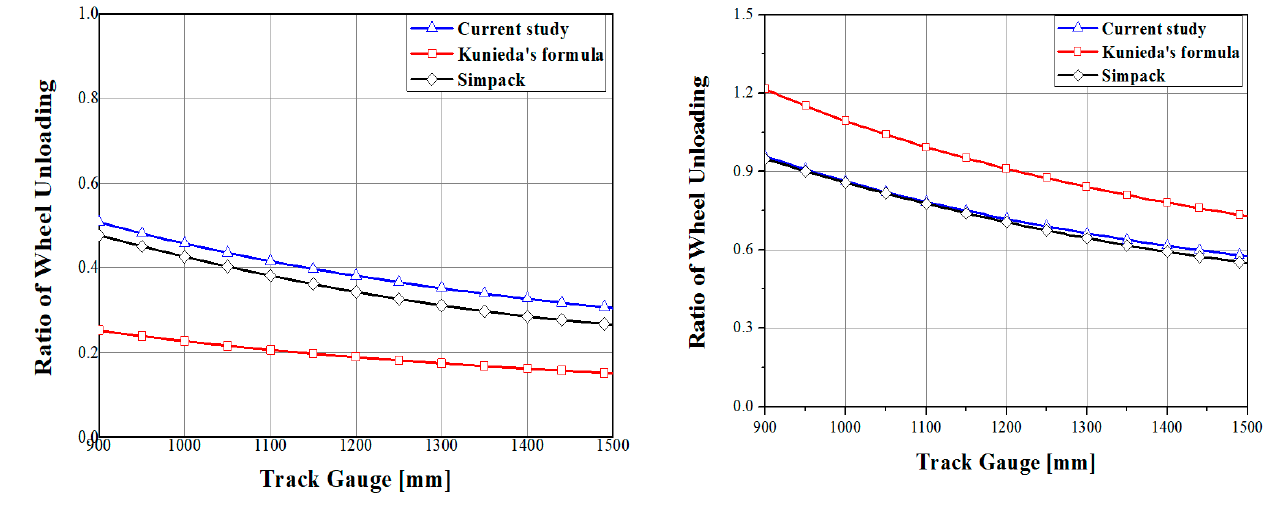
Figure 16. The ratios of wheel unloading according to track gauges. The deviations between our formula and the MBD simulation were only about 0.04 accurate to predict derailment risks than Kunieda’s formula when considering